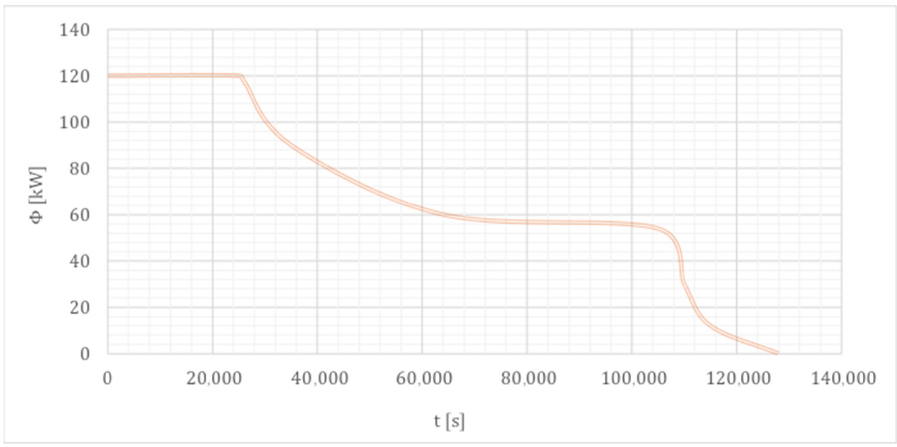
Figure 1. Thermal release evolution for the latent heat storage.